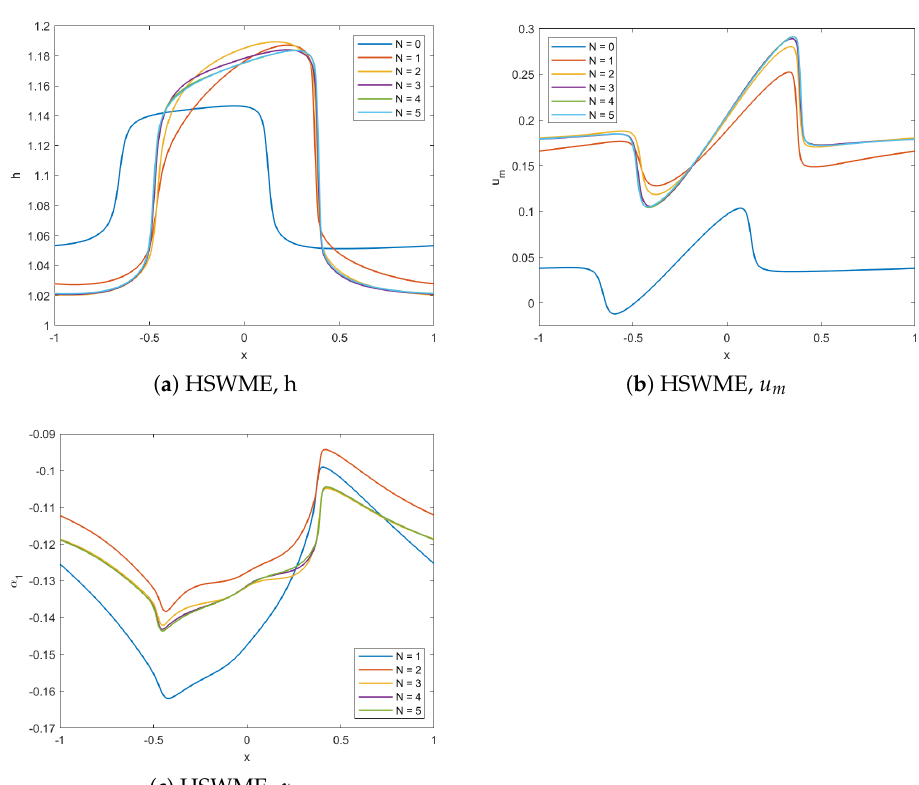
Figure 17. Standard smooth periodic test case with standard parameters [3] for varying N at t = 0.2 shows the convergence of the HSWME model.